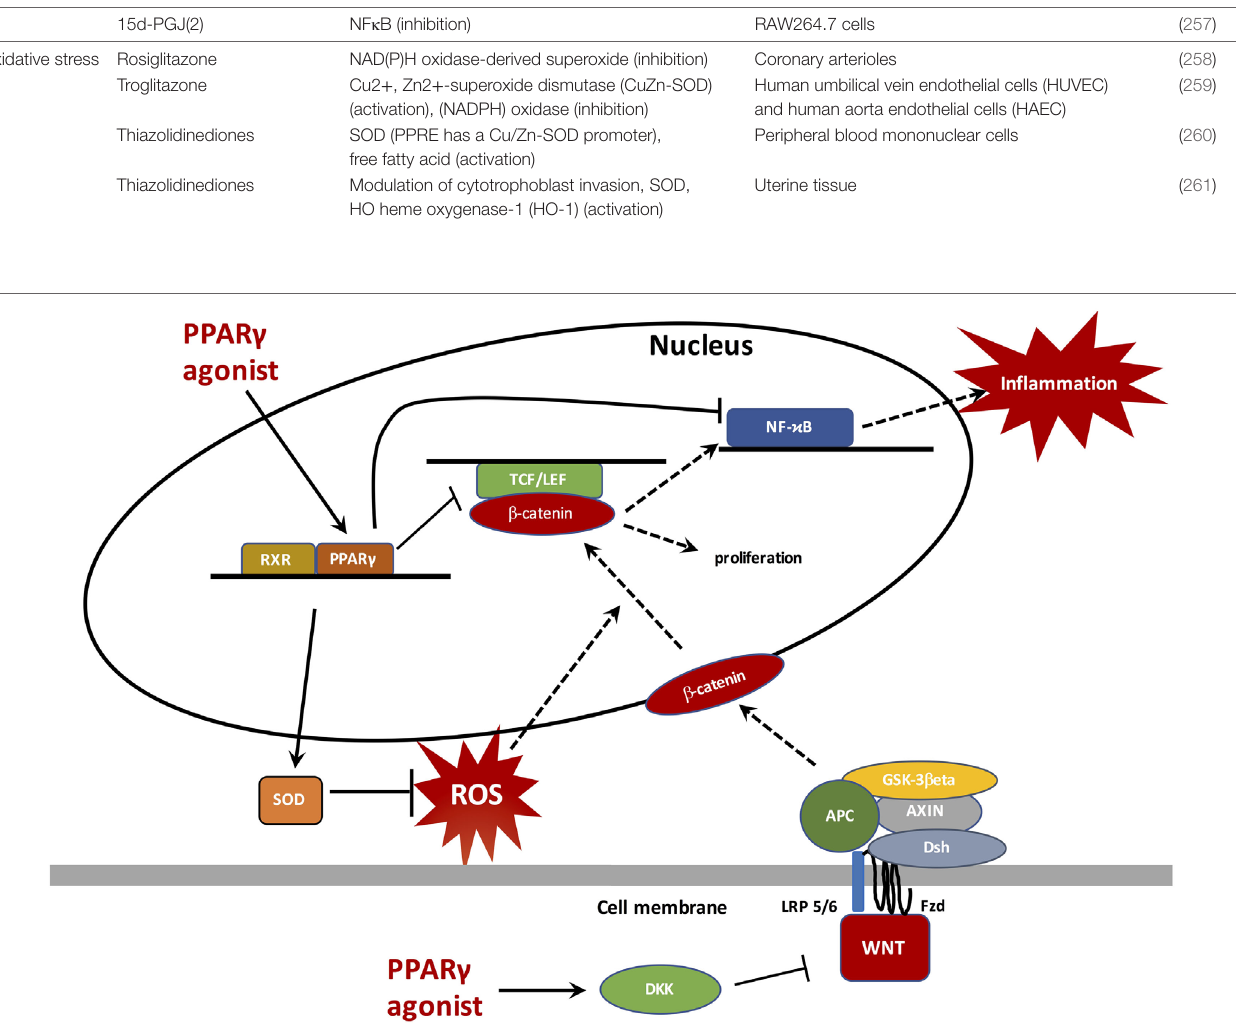
FiGURe 4 | Peroxisome proliferator-activated receptor gamma (PPAR γ ) translocates to the nucleus to bind with retinoid X receptor (RXR) and then activates PPAR response elements (PPREs), such as superoxide dismutase (SOD) to inhibit reactive oxygen species (ROS) generation. ROS inhibition does not stimulate the β -catenin nuclear transcription and therefore does not activate proliferation processes and the NF κ B pathway. PPAR γ , through its anti-inflammatory role, inhibits NF κ B and decreases inflammation. Through a catenin domain, PPAR γ directly inhibits the TCF/LEF/ β -catenin nuclear activity. In parallel, PPAR γ can activate DKK, a WNT